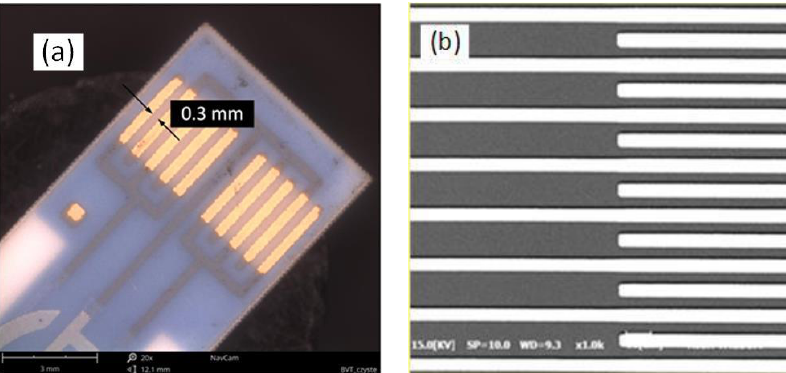
Figure 3. ( a ) Ceramic substrate (BVT Technologies) with masking layer (blue) enabling deposition of two samples in the same process and ( b ) Si/SiO 2 substrate with interdigitated gold electrodes manufactured with the help of lithography technology.